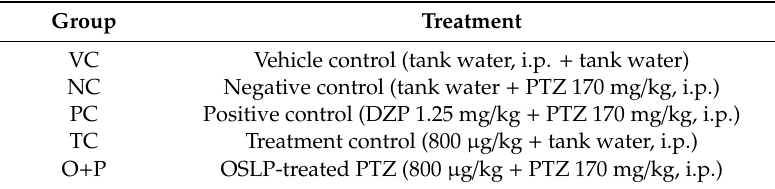
Table 2. Experimental groups in the evaluation of OSLP anti-convulsive